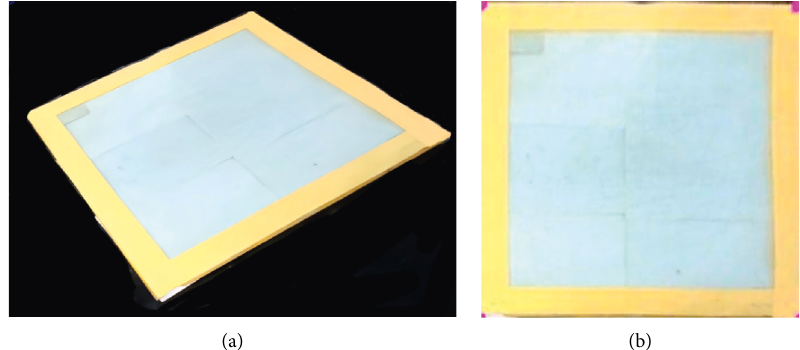
Figure 3: Correction results of automatic point selection method: (a) original image; (b) corrected